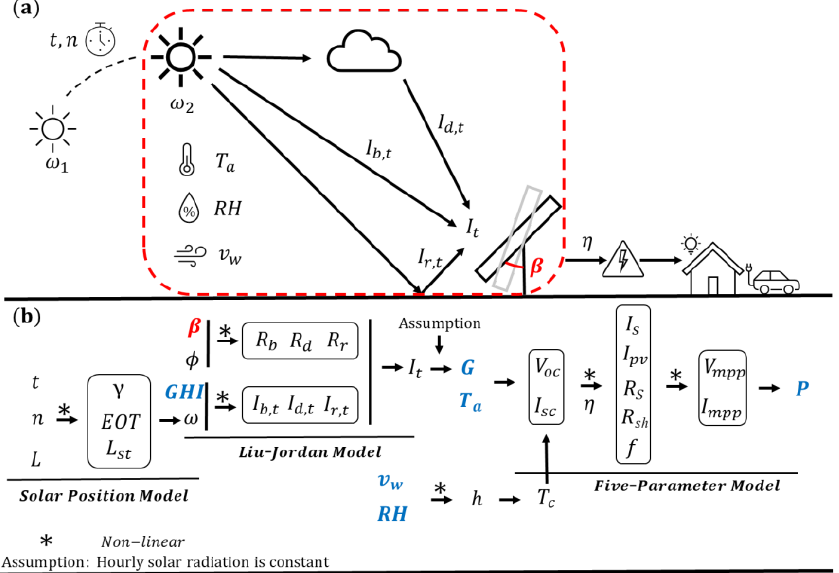
Figure 1. ( a ) Schematic of energy flow and ( b ) functional relationship of model